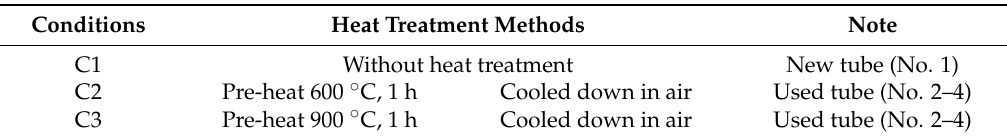
Table 2. Heat treatment